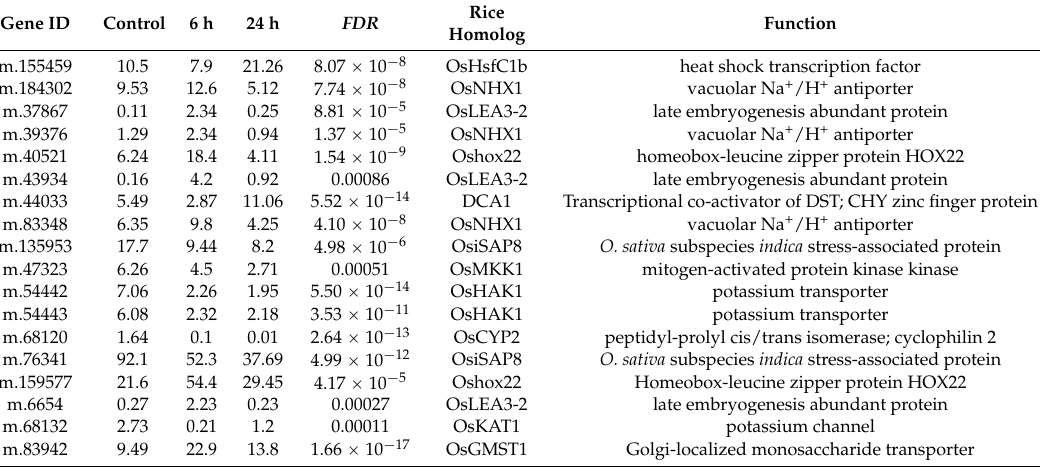
Figure 4. Hierarchical cluster analysis of DEGs under salt treatment in A. splendens . Table 2. DEGs involved in the salinity response and their homologs in the rice genome.